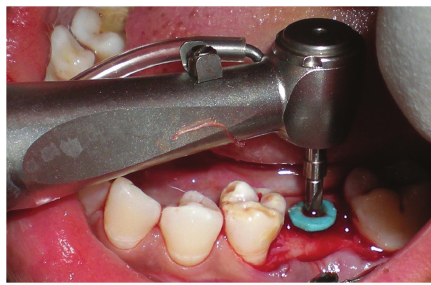
Figure 5: Pilot drill is used to increase the osteotomy site to confirm position and angulation.